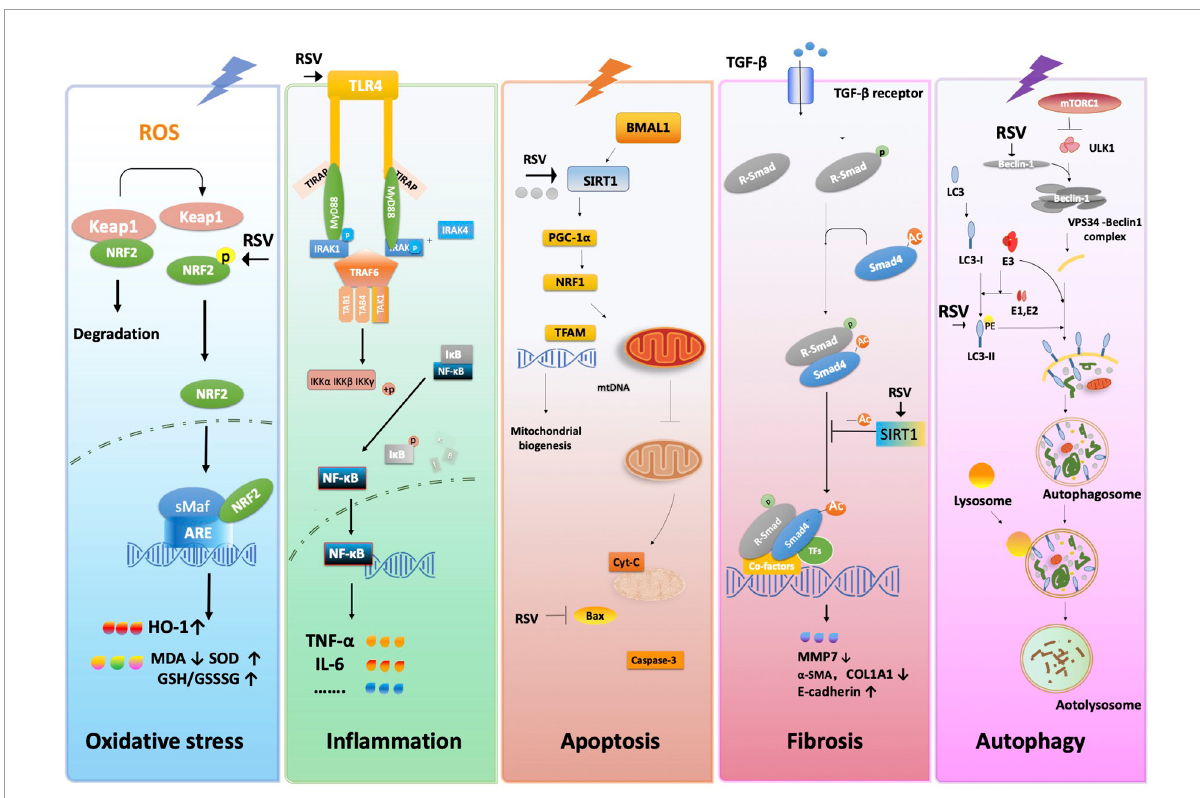
FIGURE8 The proposed molecular and cellular mechanism of the protective effect of resveratrol for renal I/R injury. The figure was created based on the data of the studies. ARE, antioxidant response element; α -SMA, α -smooth muscle actin; Bax, BCL2-associated X; BMAL1, gene BMAL1; COL1A1, collagen type I alpha 1 chain; Cyt-C, cytochrome C; GCL, glutamate-cysteine ligase; GSR, GSH S -reductase; HO-1, heme oxygenase-1; I κκ , inhibitor of nuclear factor kappa kinase; I κ B, inhibitor of NF- κ B; IL-6, interleukin-6; IRAK1, interleukin-1 receptor-associated kinases; Keap1, kelch-like ECH-associated protein 1; MMP-13, matrix metallopeptidase 7; mtDNA, mitochondrial DNA; mTORC1, mTOR complex 1; Myd88, myeloid differentiation factor 88; NF- κ B, nuclear factor-kappa B; Nrf2, nuclear factor E2-related factor 2; PE, phosphatidylethanolamine; PGC-1 α , peroxisome proliferator-activated receptor gamma co-activator 1 alpha; ROS, reactive oxygen species; R-SMAD, regulatory SMADs; RSV, resveratrol; SIRT-1, sirtuin-1; sMaf, small Maf; TAB1, TGF- β - activated protein kinase 1; TAK1, transforming growth factor beta-activated kinase1; TFAM, mitochondrial transcription factor A; TFs, transcription factors; TGF- β 1, transforming growth factor- β ; TIRAP, toll interleukin 1 receptor domain containing adapter protein; TLR4, toll-like receptor 4; TNF- α , tumor necrosis factor- α ; TRAF6, tumor necrosis factor receptor-associated factor